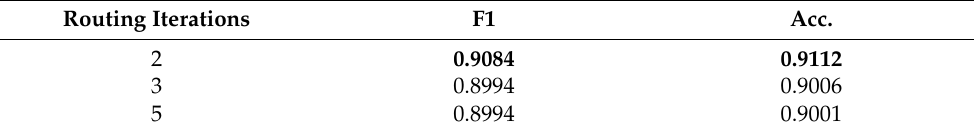
Table 17. Intent detection results by varying routing iterations in the proposed U-IntentCapsNet model.